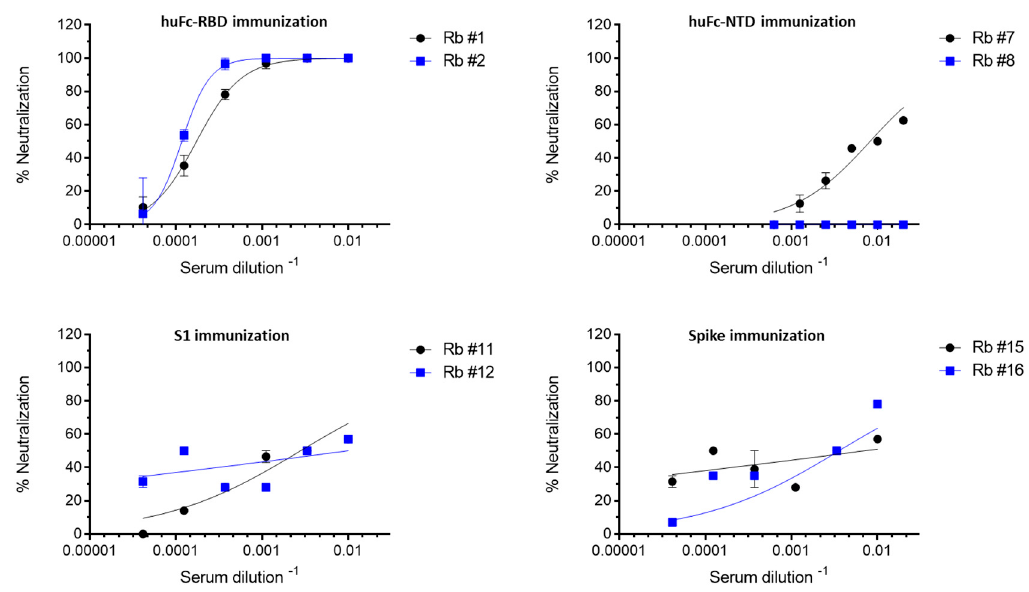
Figure 3. SARS-CoV-2 neutralization activity of immunized rabbits’ sera. Serum neutralization activity against SARS-CoV-2 was evaluated by the ability to reduce plaques formation. Results are expressed as percent inhibition of control without Ab. Points are average of duplicates ± SEM fitted by non-linear regression and represent two independent experiments obtaining similar results.